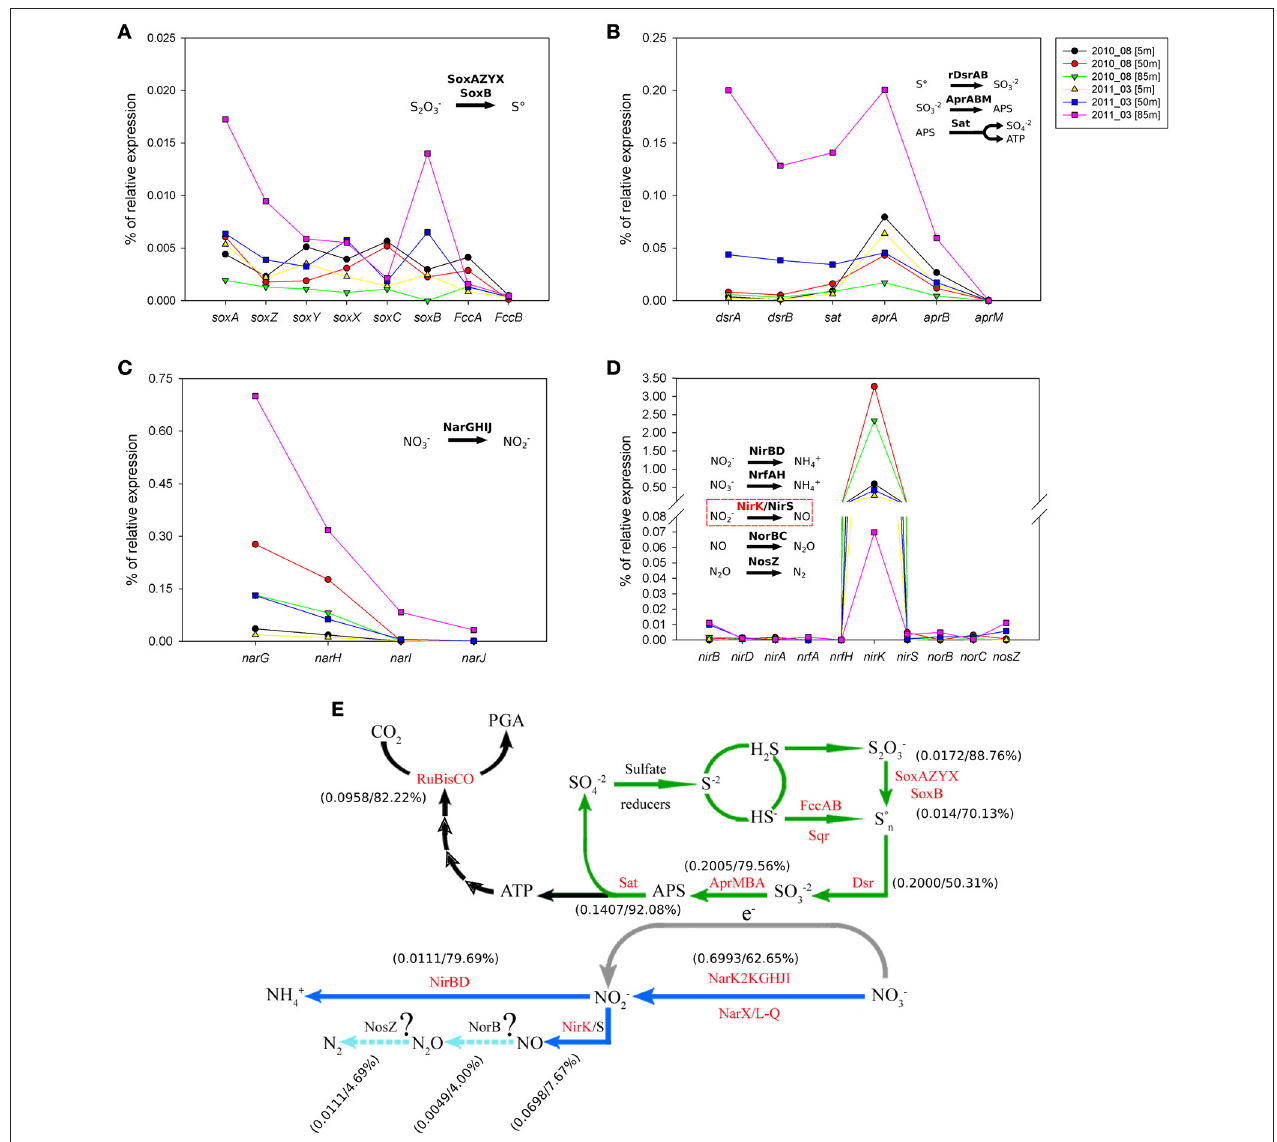
FIGURE 10 | Percentage of relative expression for key genes of the sulfur and nitrogen cycles that could be coupled to carbon fixation via RuBisCO in the chemolithoautotrophic metabolisms of the OMZ. Panel (A) shows the expression of the sulfur oxidation system ( sox ) genes. Panel (B) shows the expression of the reverse dissimilatory sulfite reductase ( rdsr ) pathway, the adenosine-5 ′ -phosphosulfate reductase ( apr ) pathway and the ATP sulfurylase (sat) cysN gene. Panel (C) shows the expression of nitrate reductase gene cluster and Panel (D) shows the expression of different pathways for the utilization of nitrite; nitrite reductase nirBD genes (ammonium formation); nitrite reductase formate-dependent nrfAH genes (ammonium formation); nitrite reductase nirK / nirS gene; nitric oxide reductase norBC genes and the nitrous oxide reductase nosZ gene. Finally, panel (E) integrates the information of the key genes presented in panels (A–D) , into previously proposed coupling of the carbon, sulfur and nitrogen cycles in the OMZ by the GSO group (based in metagenomics analysis), modified from Murillo et al. (2014), in which as been included the relative expression of key genes and the percentage of sequences expressed that associate to the GSO group for each given gene. In the case of the gene operons, the data presented correspond to the relative expression of genes: soxA , rdsrA , aprA , narG, and nirB